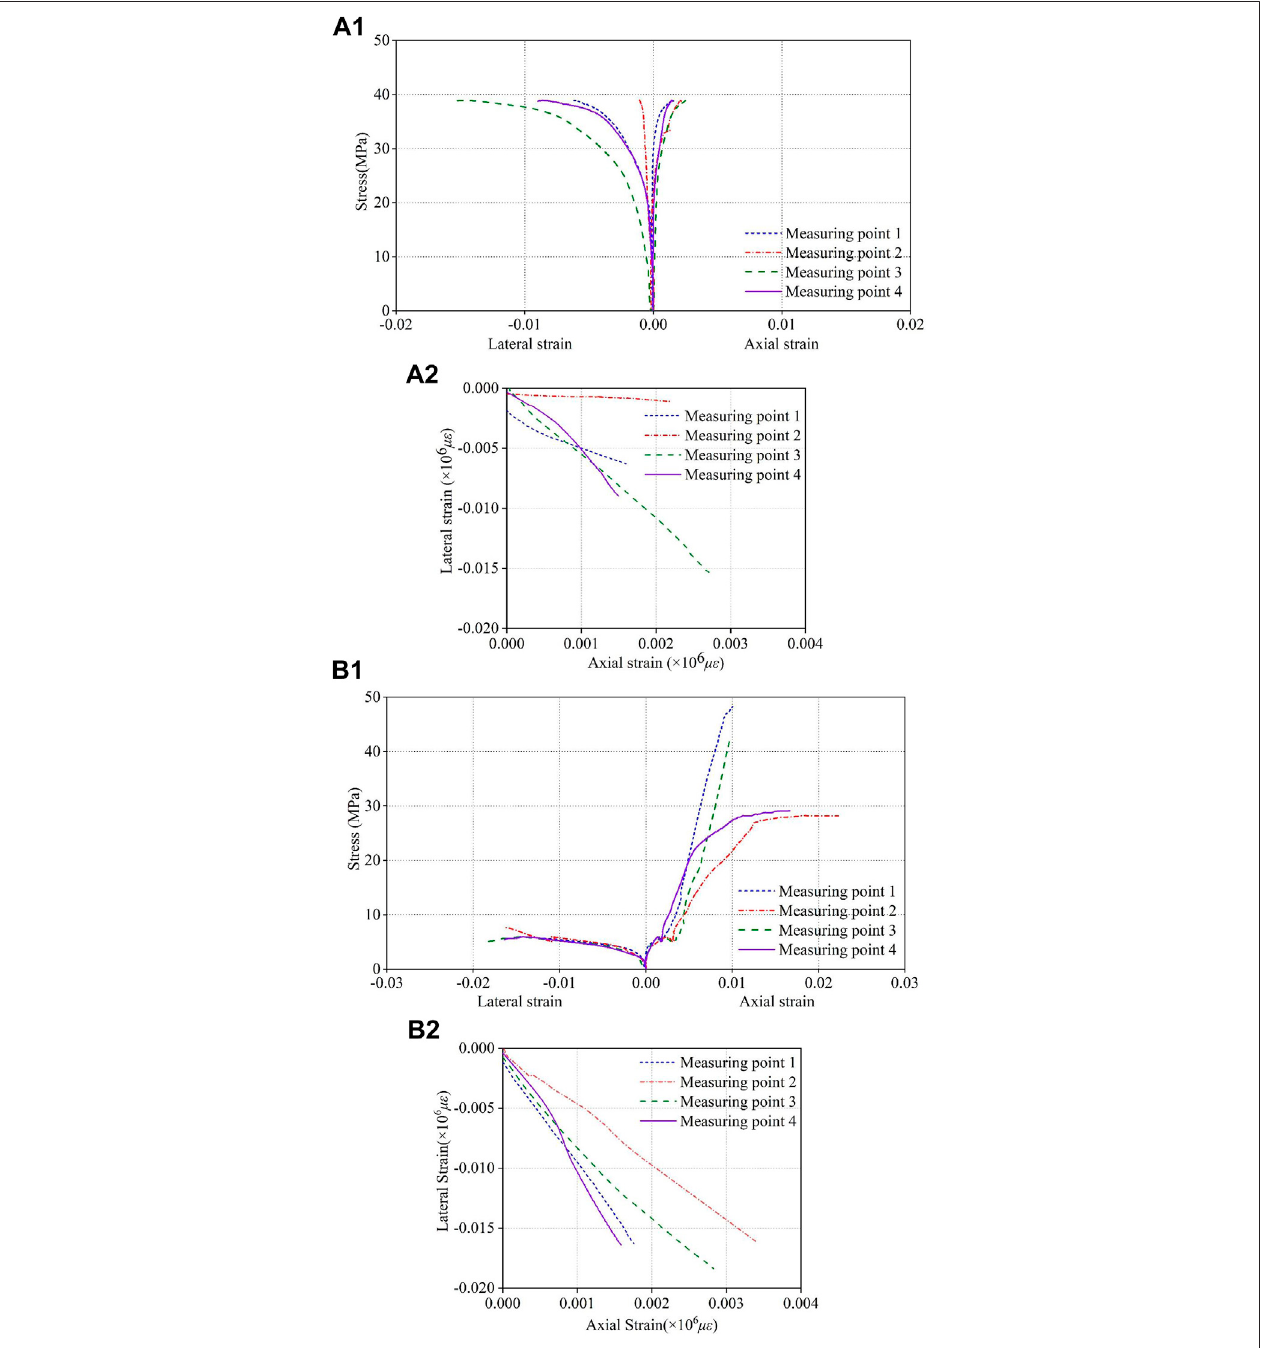
FIGURE 7 | Stress – strain curves of the three types of specimens (A1, B1, and C1) , Lateral-to-axial strain curves of the three types of specimens (A2, B2, C2) .